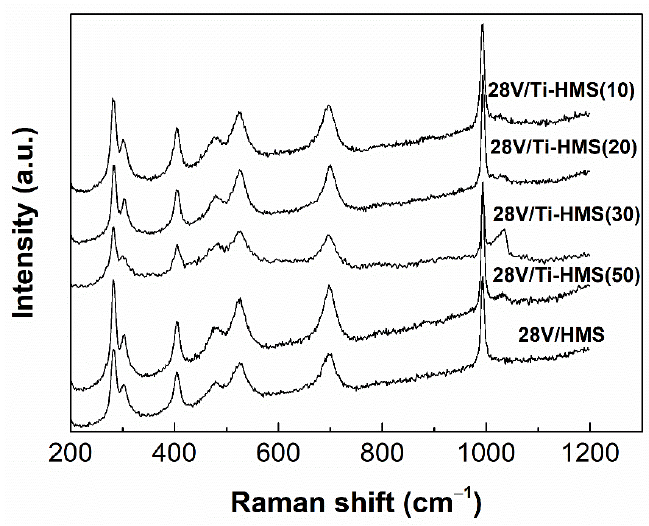
outcomes of UV-vis DRS studies.